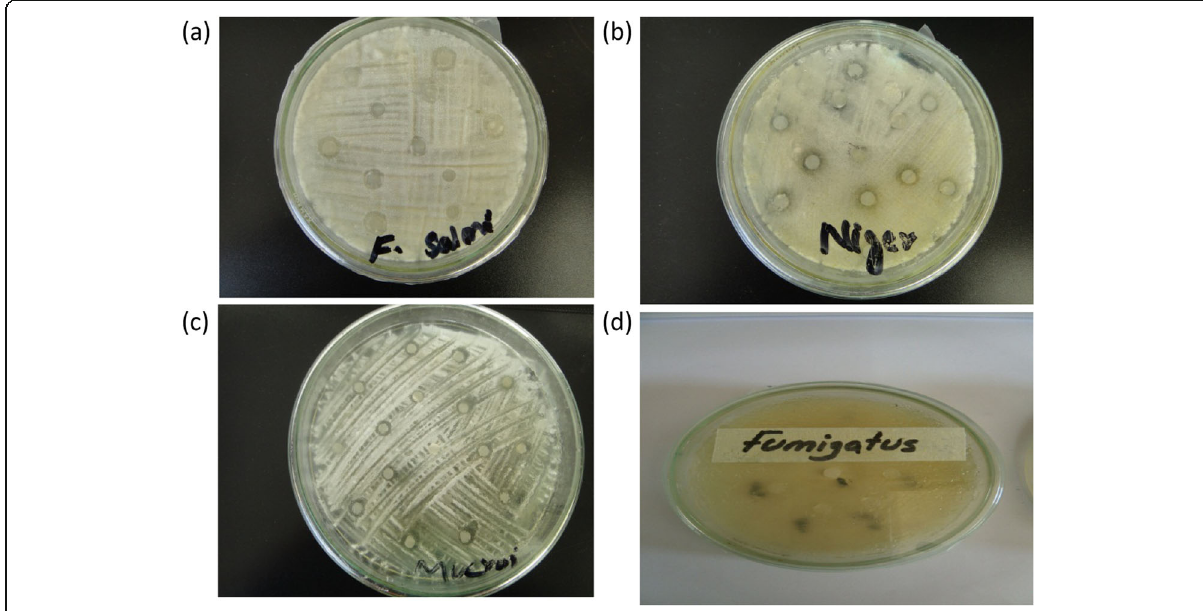
Fig. 6 Antifungal activity images of A. jacquemontii extracts against a F. soloni b A. niger c M. specie d F. fumagatus